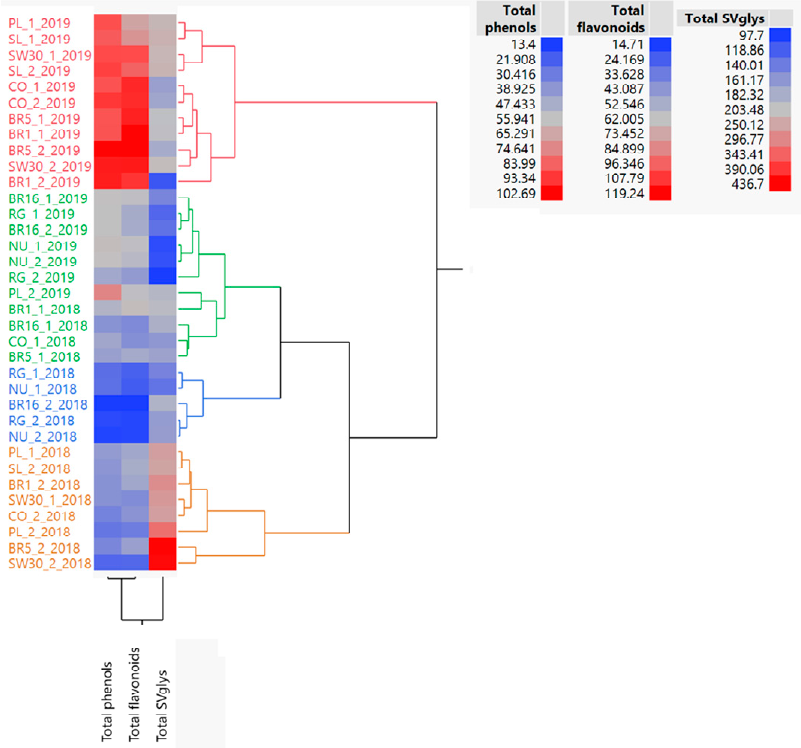
Figure 2. Hierarchical cluster analysis (HCA) on total phenols, flavonoids and SVglys. Each genotype is followed by the indication of harvest time (1 = first harvest; 2 = second harvest) and crop age (2018